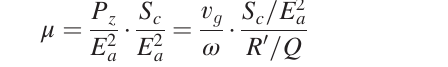
(center), normal- a =E 2 (right) in a regular cell c a